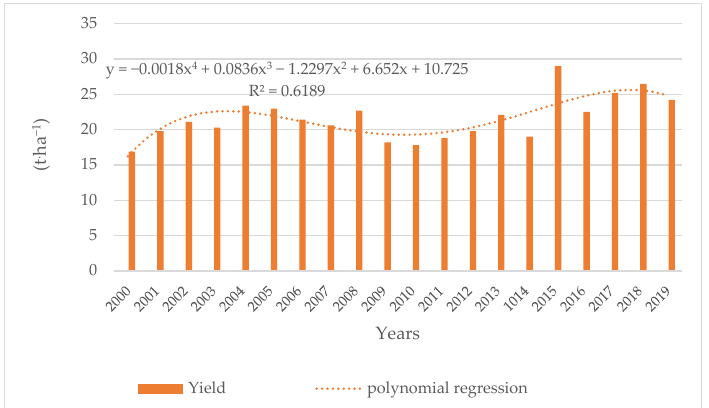
Figure 2. Variability of the total yield of potato tubers in Southeastern Poland in 2000 – 2019. Potato yields in cultivar experiments were characterized by even greater yield variability in this part of Poland. In terms of the total and commercial yield, the yield of very early cultivars was the most diverse, ranging from 30 to 65 t . ha −1 in the case of the total yield and from 37 to 62 t . ha −1 in the case of the commercial yield. The most stable in yieldings were medium-late and late cultivars, and their total yield ranged from 40 to 58 t . ha −1 , and the marketable yield ranged from 38 to 52 t . ha −1 (Figure 3).